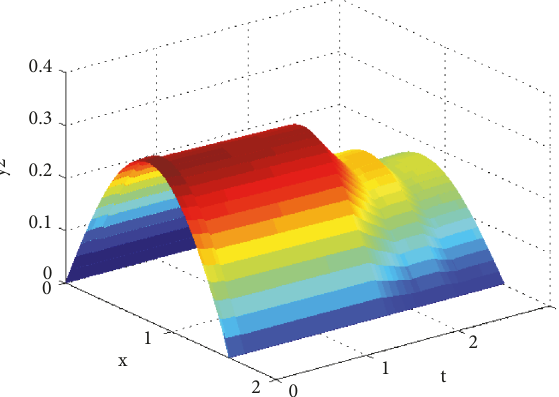
Figure 3: The open-loop trajectory of 𝑦 2 (𝑥, 𝑡) .